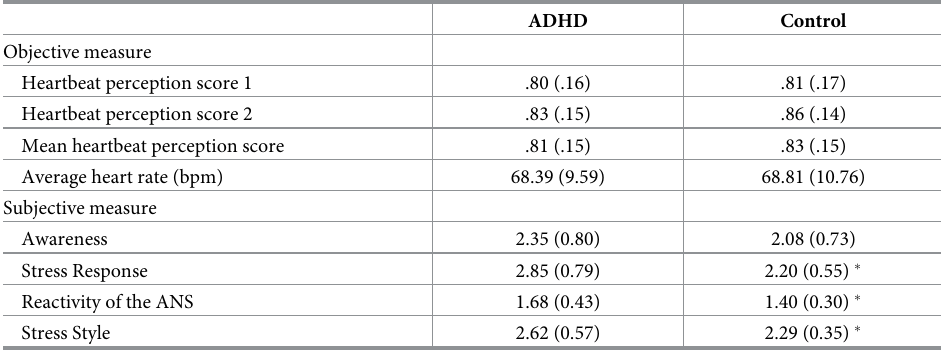
Table 1. Scores on the objective and subjective measure of interoceptive awareness, separated per group.